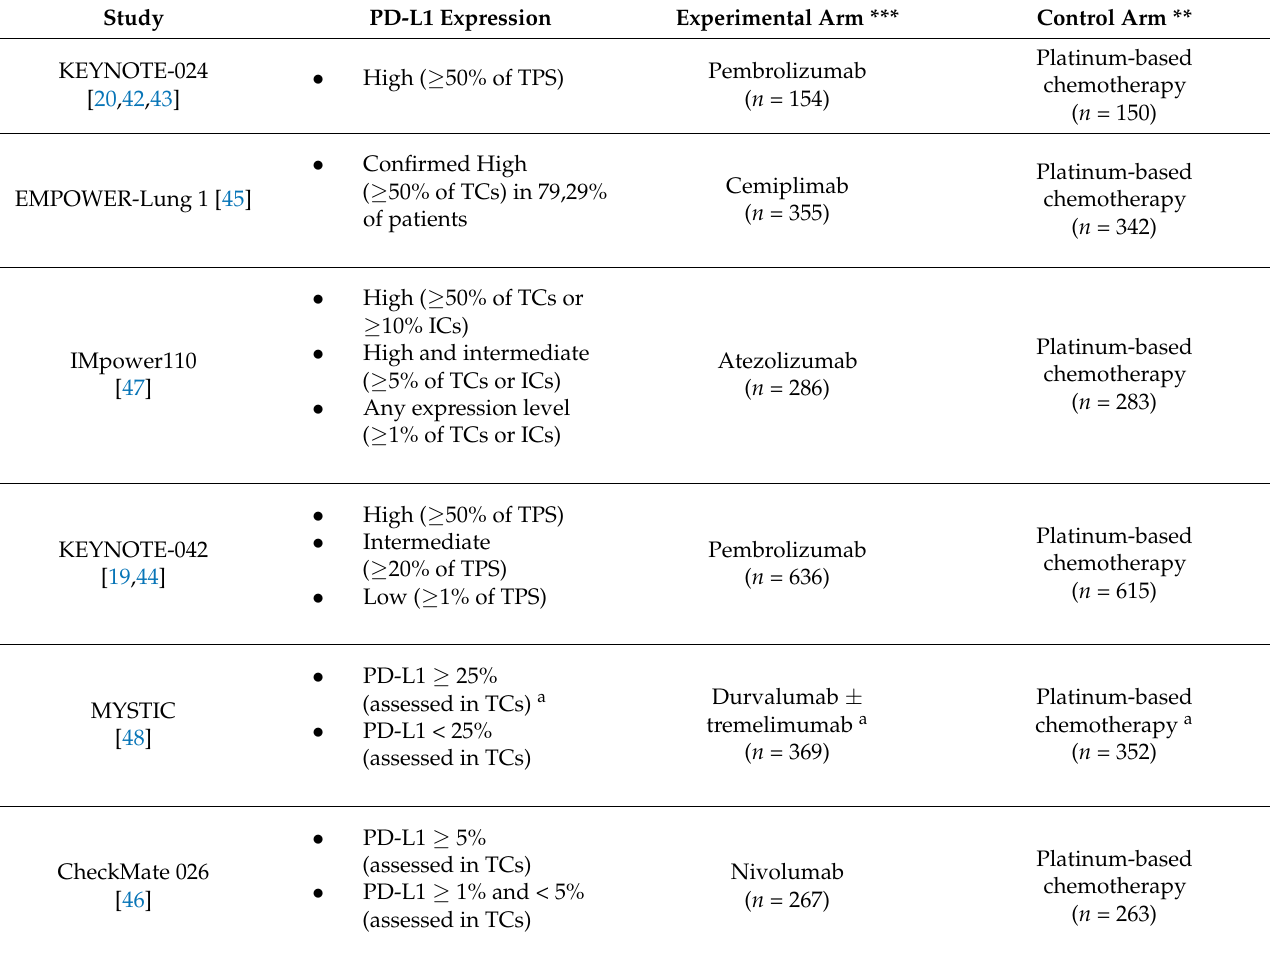
Table 1. Characteristics of the studies included in the